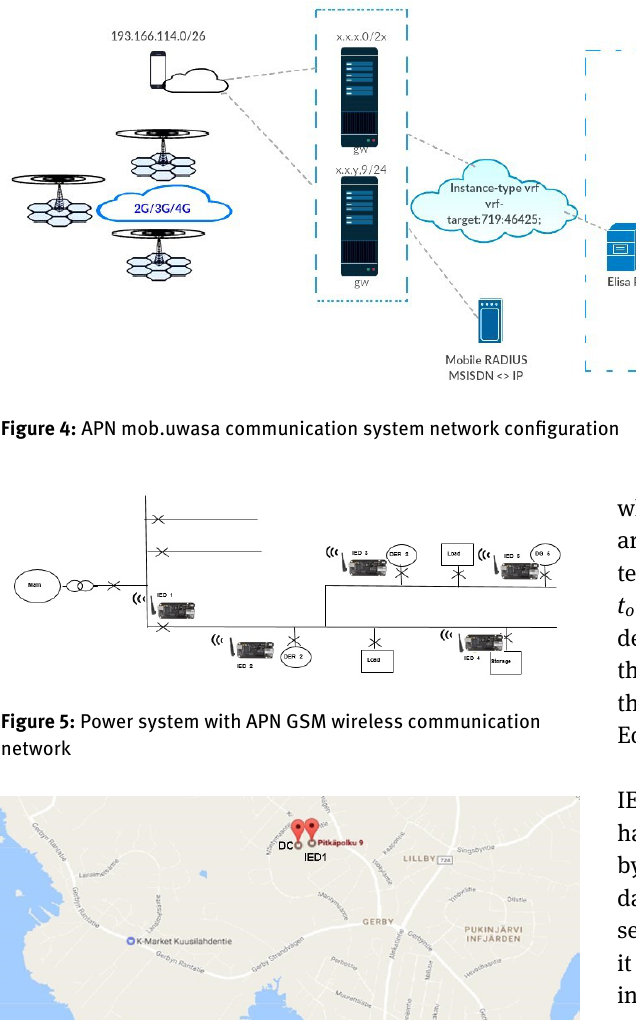
formance as illustrated in (1) and